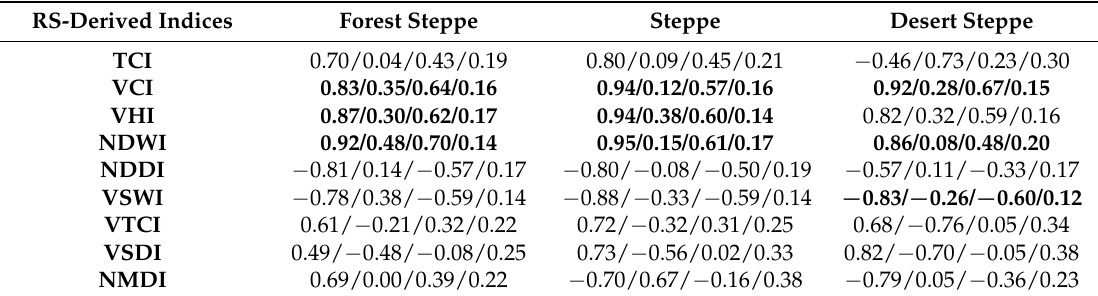
Table 5. R of the NorBio and RS-derived drought indices in three land-cover types across stations (at a 99% confidence level).